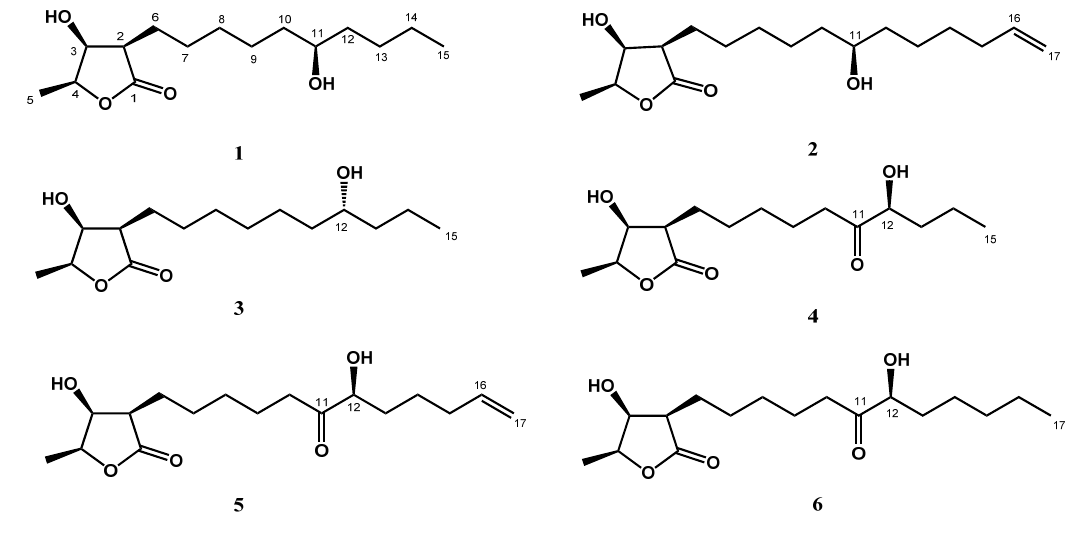
Figure 1. Structures of new compounds 1 – 6 . Table 1. 1 H and 13 C-NMR data of machinolides A–C ( 1 – 3 ).